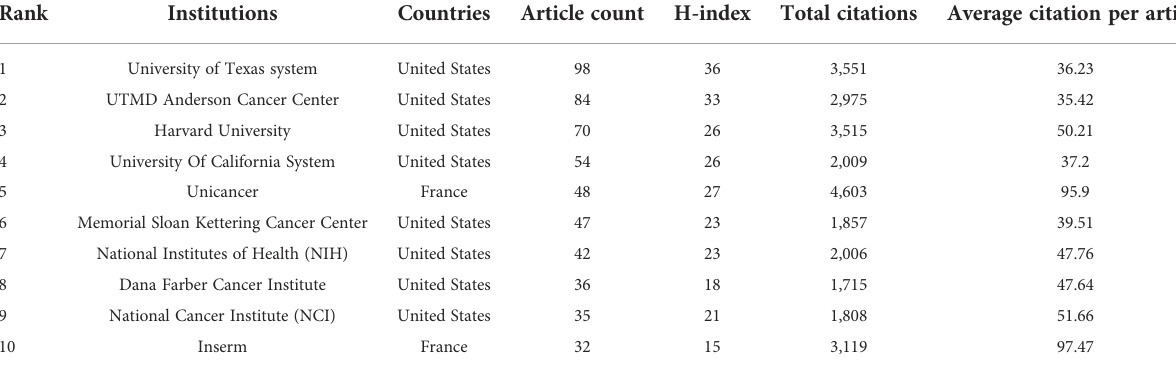
Figure 6 was a dual-map overlay of the relevant journals, whichrevealedthecitationrelationshipsofthejournalamongrelated fi eldsthroughvisualization.Thelabelsonthemaprepresentthe fi eld towhichthejournalbelongs.Theleftsideofthemaprepresentedthe fi eldofcitingliterature,andtherightsiderepresentedthe fi eldofcited literature. Different colors represented different citation paths. The fi gureidenti fi edthreemaincitationpaths,includingtwogreenpaths and one orange path. The orange line showed that the includes articlesweremostlydistributedinthe fi eldsofMolecular,Biologyand Immunology, while the cited articles were mostly distributed in the fi elds of Molecular, Biology and Genetics. The green path indicated thatthearticlesincludedintheanalysisweremostlydistributedinthe fi elds of Medicine, Medical and Clinical, while the cited articles were mostly distributed in the fi elds of Molecular, Biology, Genetics, Health, Nursing and Medicine. The determination of citation path can represent the causal relationship of citation. The citing literature can be regarded as the applied research in this fi eld, while the cited literature can be regarded as the research basis in this fi eld.